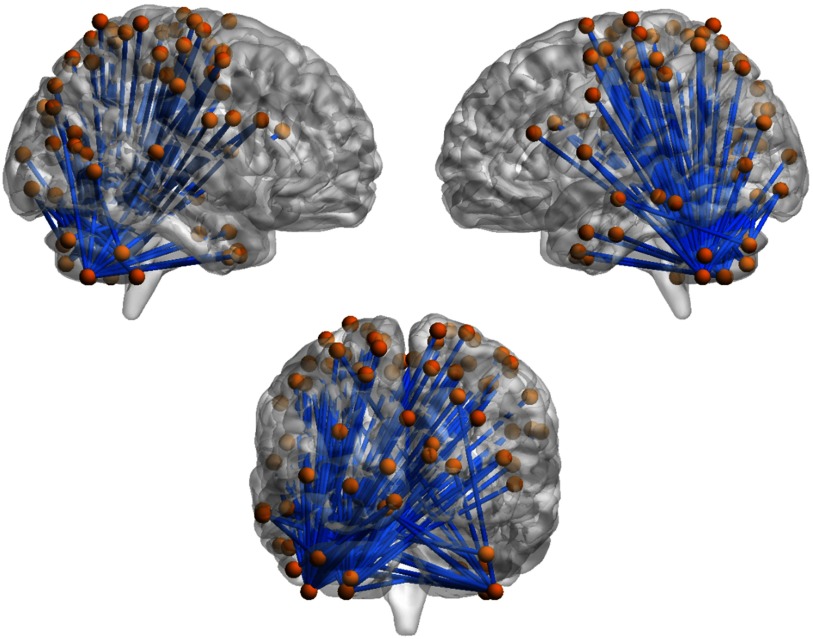
Illustration of the NBS-derived cerebellar-cortical functional network associated with short-term skill learning. Spheres represent center-of-gravity coordinates of the NBS-derived regions. Images are visualized using BrainNet Viewer (Xia, Wang, & He, 2013). Detailed information can be found in Table S1 (Zang et al., 2018).